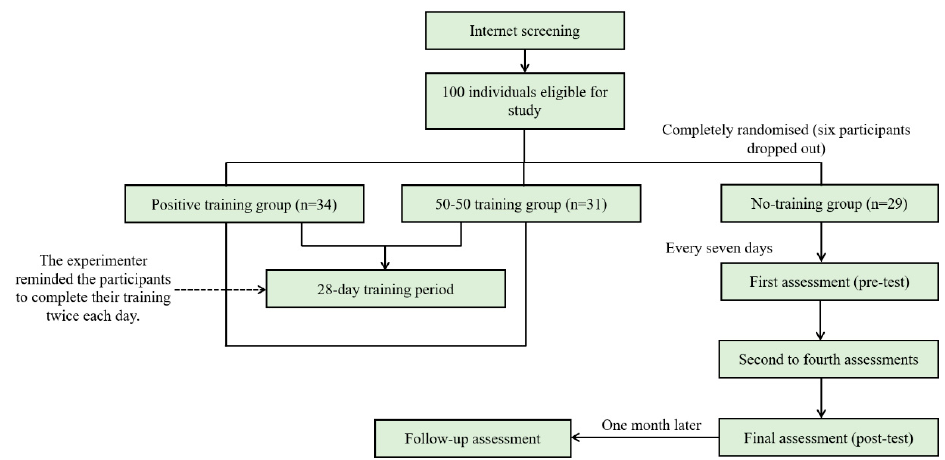
Figure 3. Flowchart showing the experimental study procedure.